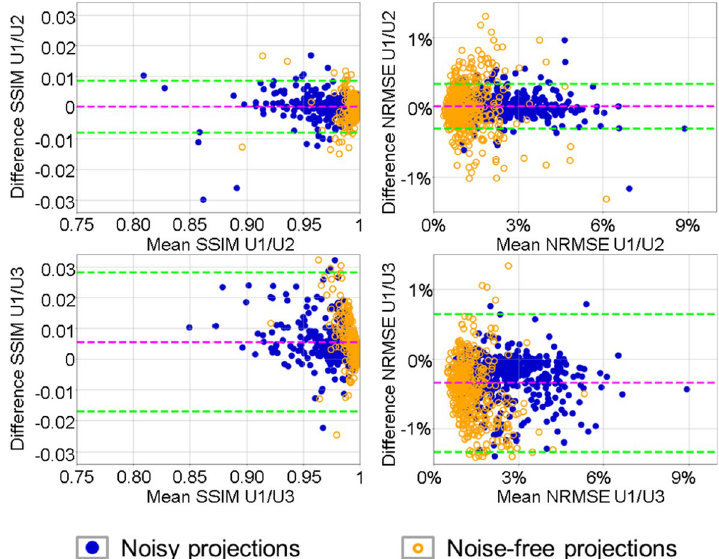
Fig. 5 Bland–Altman plots illustrating the performance of u‑nets U2 and U3 in comparison with U1. Bland– Altman plots for the differences in SSIM and NRMSE between synthetic projections of u‑net U1 and U2 (top) and U3 (bottom). Blue circles depict the differences for the noisy projections, while the orange circles depict the differences for the noise‑free projections. The magenta lines indicate the mean difference of the values for the noisy projections, and the green lines indicate the 95% confidence